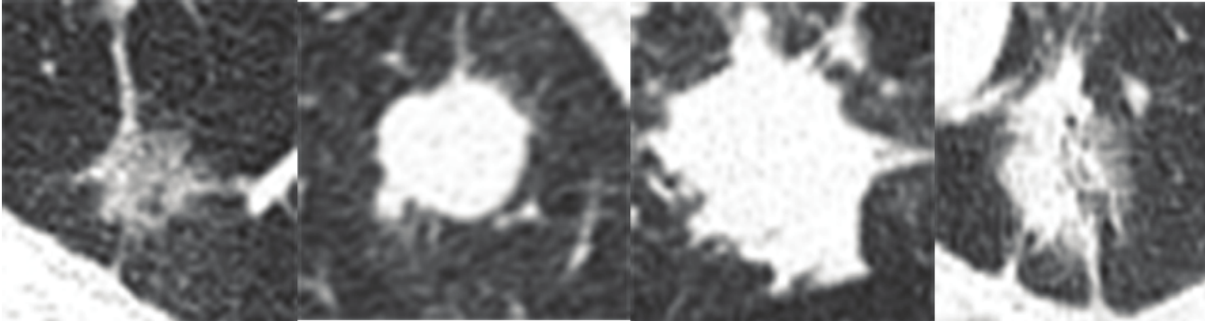
Figure 1: CT images of lung cancer pathological types: from left to right are ISA (adenocarcinoma in situ), SCLC (small cell lung cancer), SCC (squamous cell cancer) and IA (invasive adenocarcinoma). The green box areas are ROI areas of tumors.